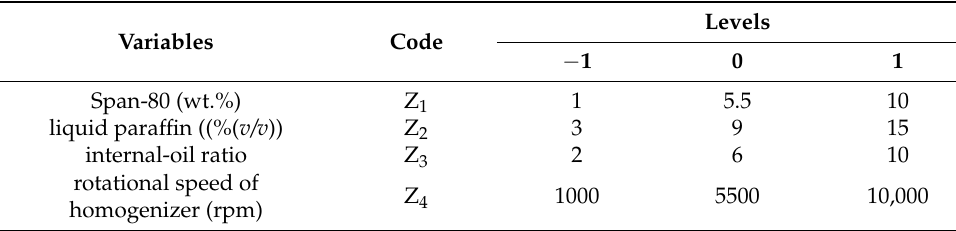
Table 2. Factor variables and different level values in BBD design.